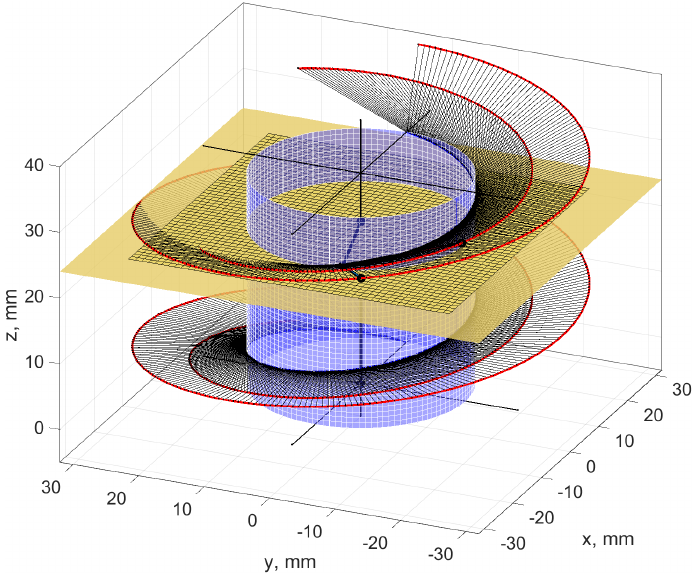
Figure 3. Convolute helical surface.